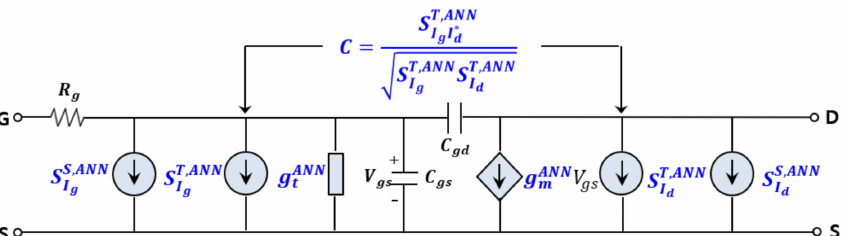
Figure 2. Neural-based small-signal equivalent circuit model of a quasi-ballistic MOSFET for high fre- quency noise analysis. The model describes the drain, gate, correlation noise source, and conductance as well as the gate and drain shot noise